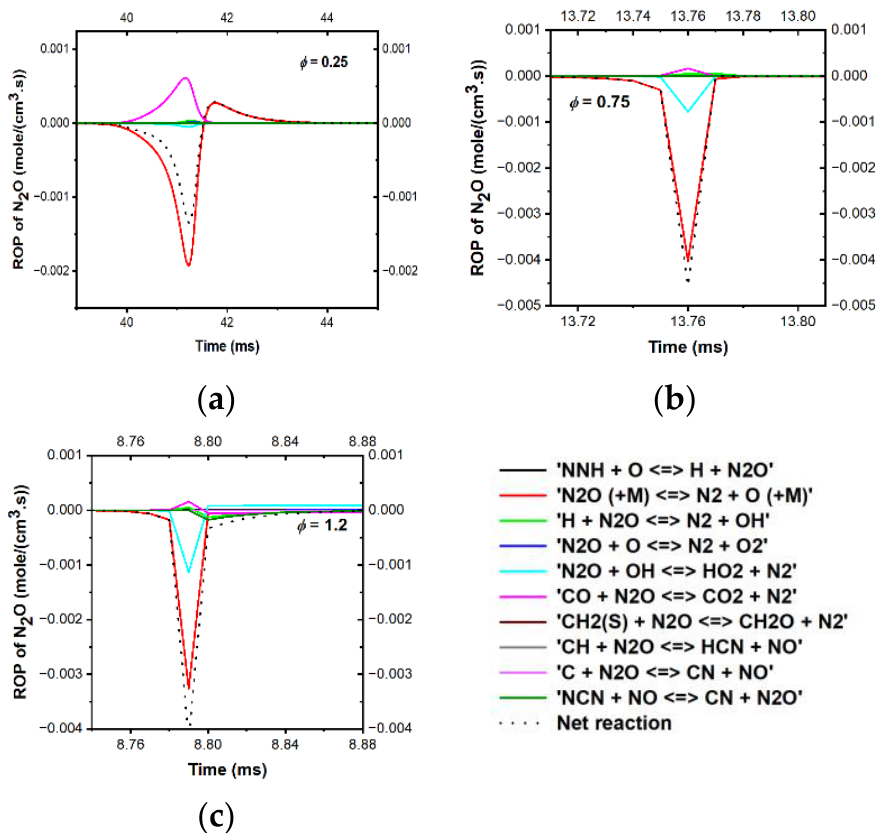
Figure 18. ROP analysis of N 2 O for the oxidation of tert-butanol at ( a ) φ = 0.25, ( b ) φ = 0.75 and ( c ) φ = 1.2.